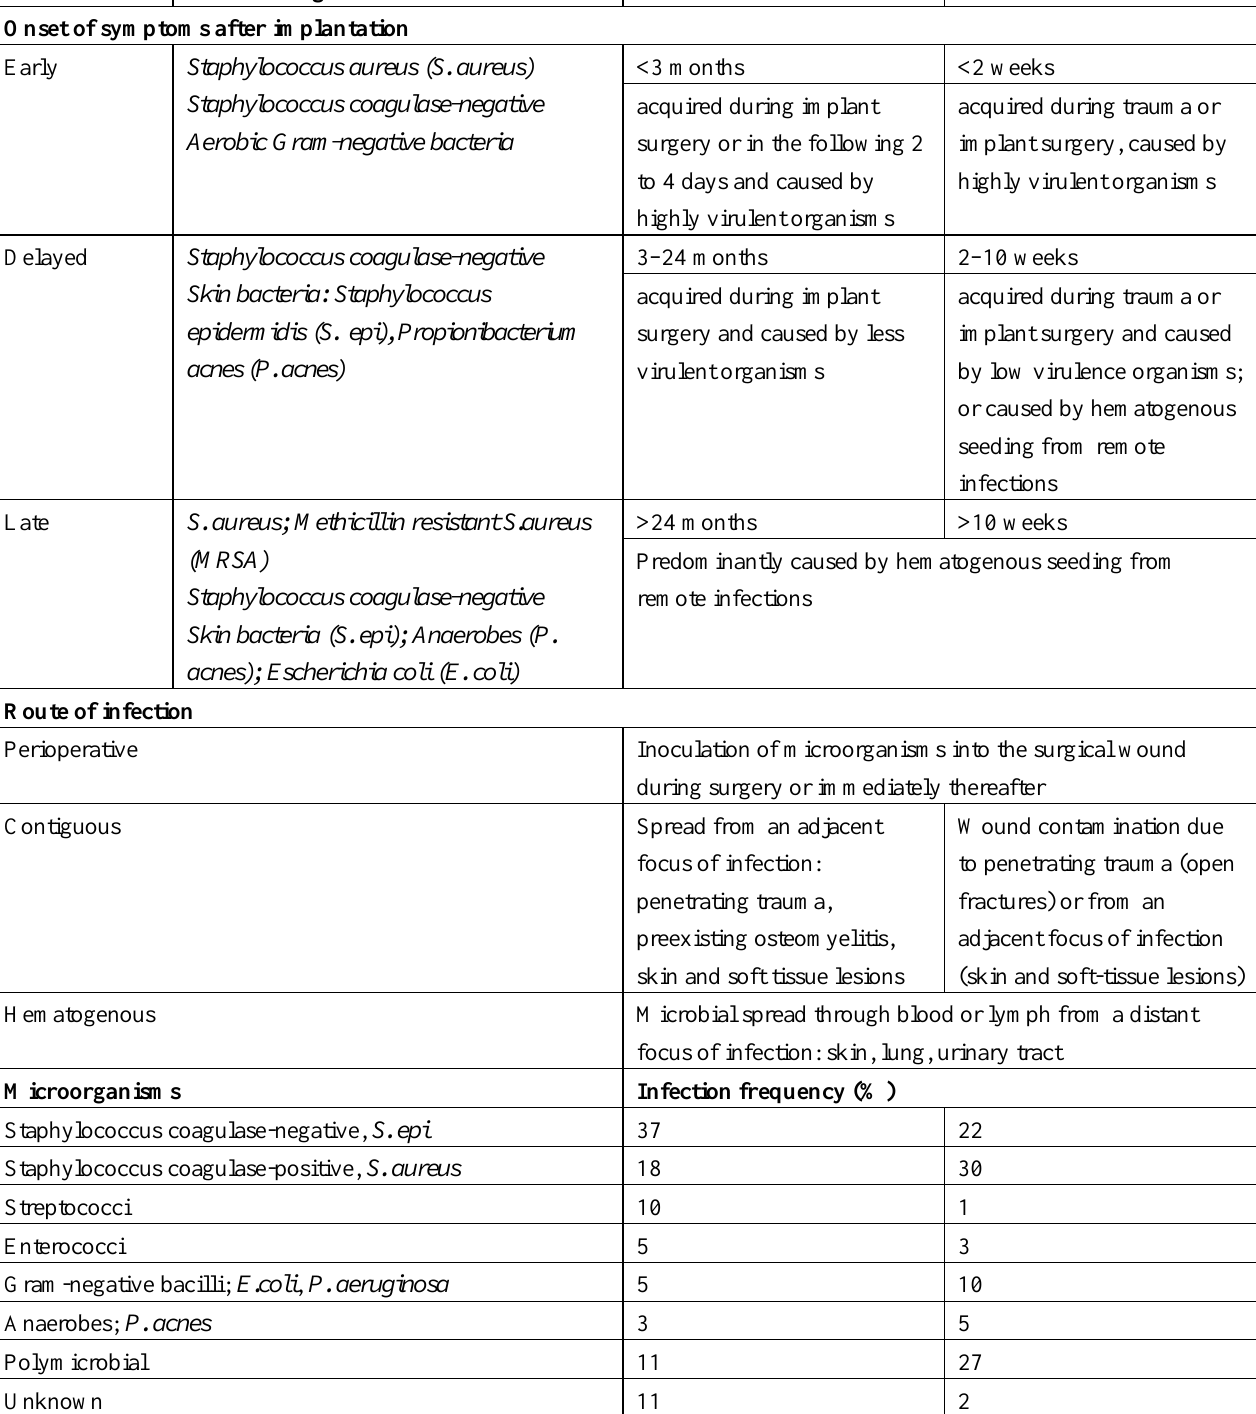
Table 1. Classification of infections adapted from